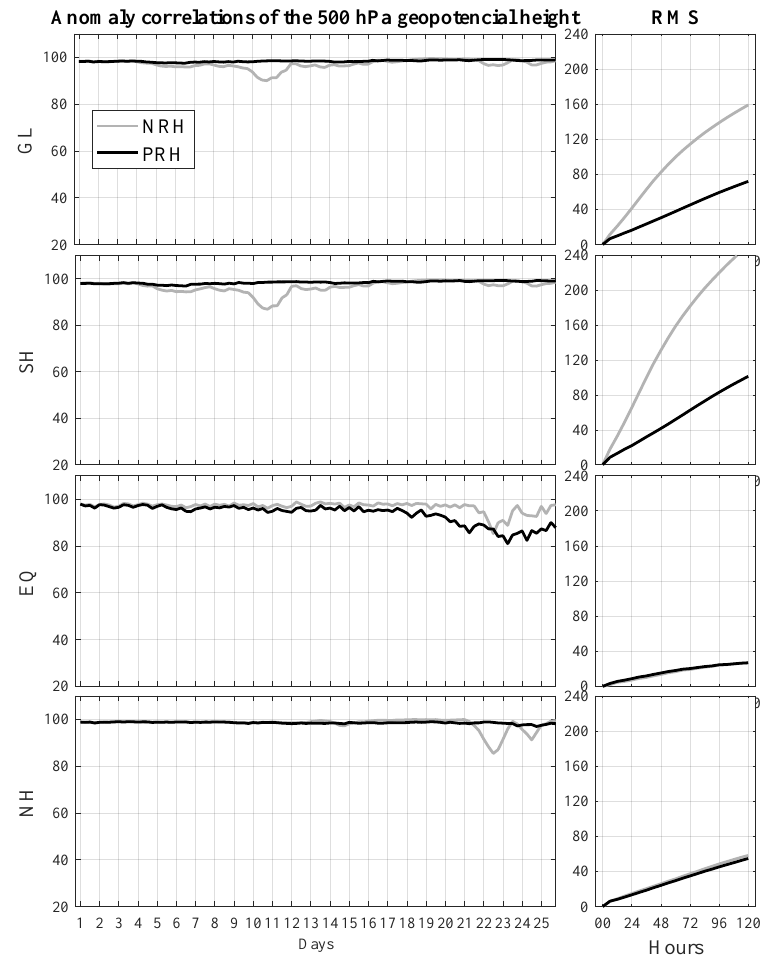
Figure 4. Temporal series of the anomaly correlation coefficient and RMS values of the 48-h forecast of the height geopotential at 500 hPa as a function of the integration time for PRH and NRH experiments in the global domains, Southern Hemisphere, Equator and Northern Hemisphere. The correlations present a statistical significance of